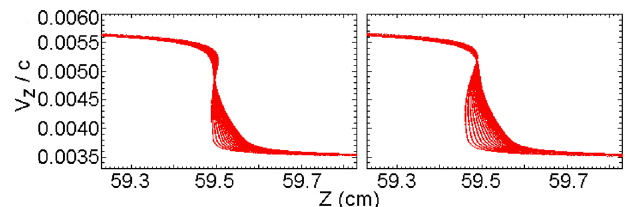
g phase space at the focal plane for the FIG. 7. (Color) f z; v z (cid:4) 0 eV , r (cid:4) 2 cm beam with a (cid:1) 20 mr convergence angle T k b at z (cid:4) (cid:1) 30 cm (left) and no convergence angle (right) using the smooth waveform across the finite-size gap. The compression ratios and full-width, half-maximum pulse lengths at focus are 2650 and 0.035 ns compared to 1500 and 0.065